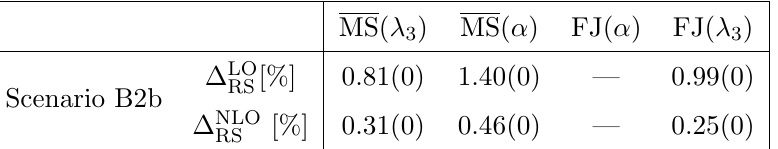
Table 8 . The variation (cid:1) RS of the h ! 4 f width in scenario B2b at the central scale (cid:22) 0 using the renormalization schemes MS( (cid:11) ), MS( (cid:21) 3 ), and FJ( (cid:11) ) (with NLO parameter conversions). The columns correspond to the schemes in which the input parameters are de(cid:12)ned. Using parameters de(cid:12)ned in the FJ( (cid:11) ) scheme, the results are unreliable, and a computation of (cid:1) RS is not meaningful. The zeroes in brackets show that the integration errors are